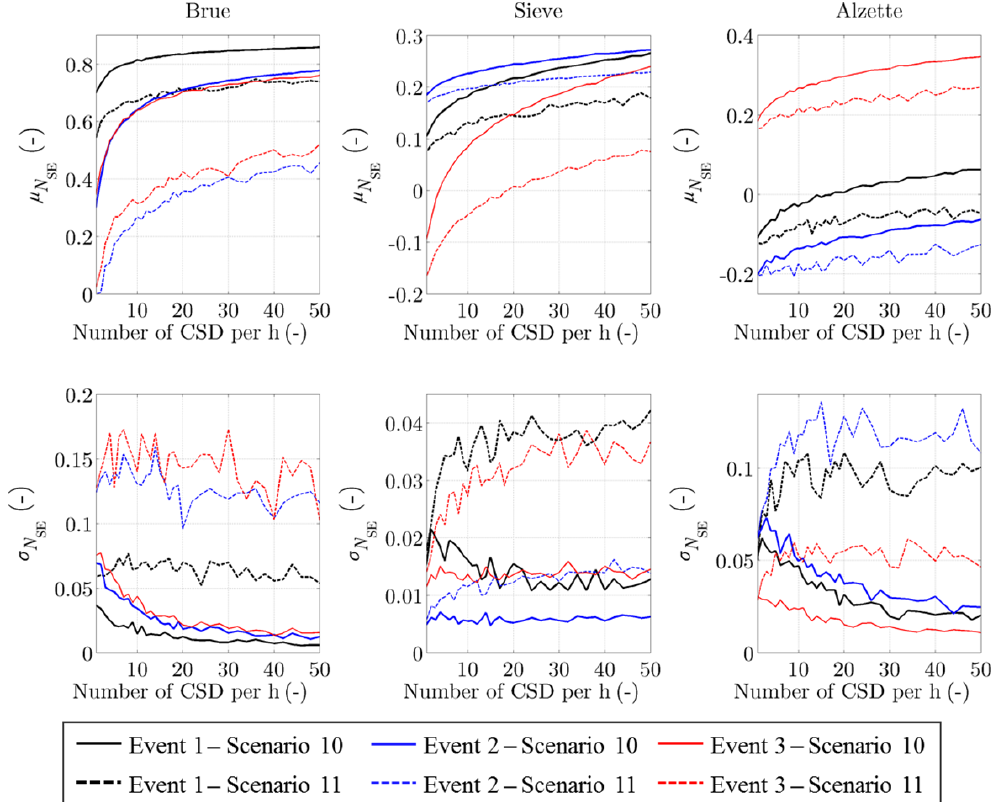
Figure 12. Dependency of the mean µ N and standard deviation σ N of the Nash–Sutcliffe efficiency sample (first row and second row, SE SE respectively) on the number of streamflow crowdsourced data in scenarios 10 (solid lines) and 11 (dashed lines) for the considered flood events (black, blue, red lines) in the three catchments: Brue (left panel), Sieve (central panels), and Alzette (right panels).